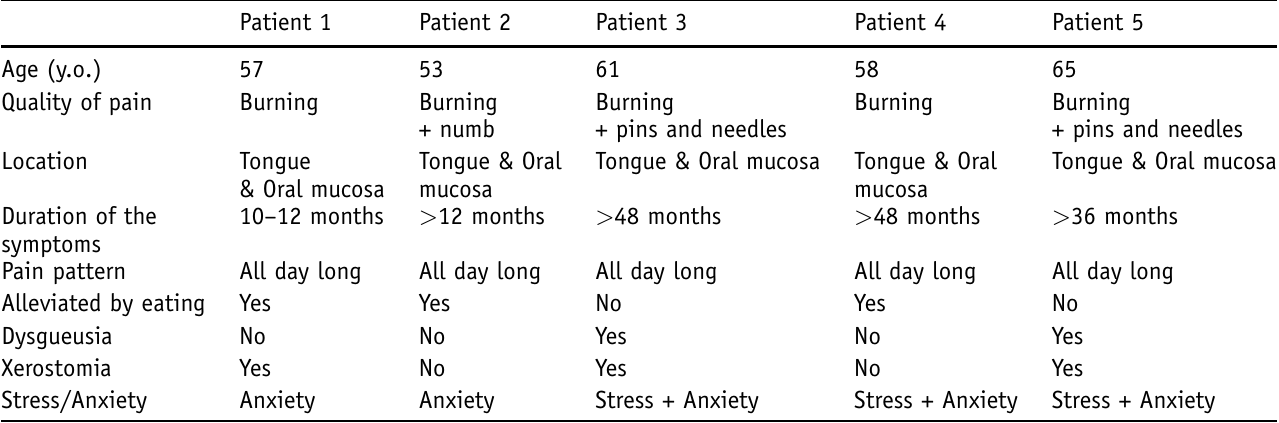
Table II. Characteristics of the BMS